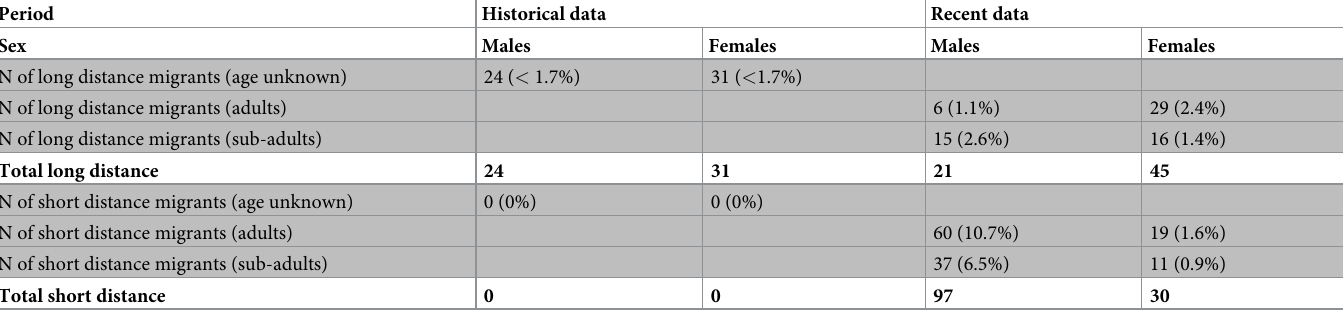
Table 2. Details of migration behaviour based on historical data (1939–1973) and recent data (2002–2015). The numbers in parentheses are the recovered fraction of the marked population, calculated for each gender. Short distances are distances less than 50 km between the summer and winter roost, long distances are more than 50